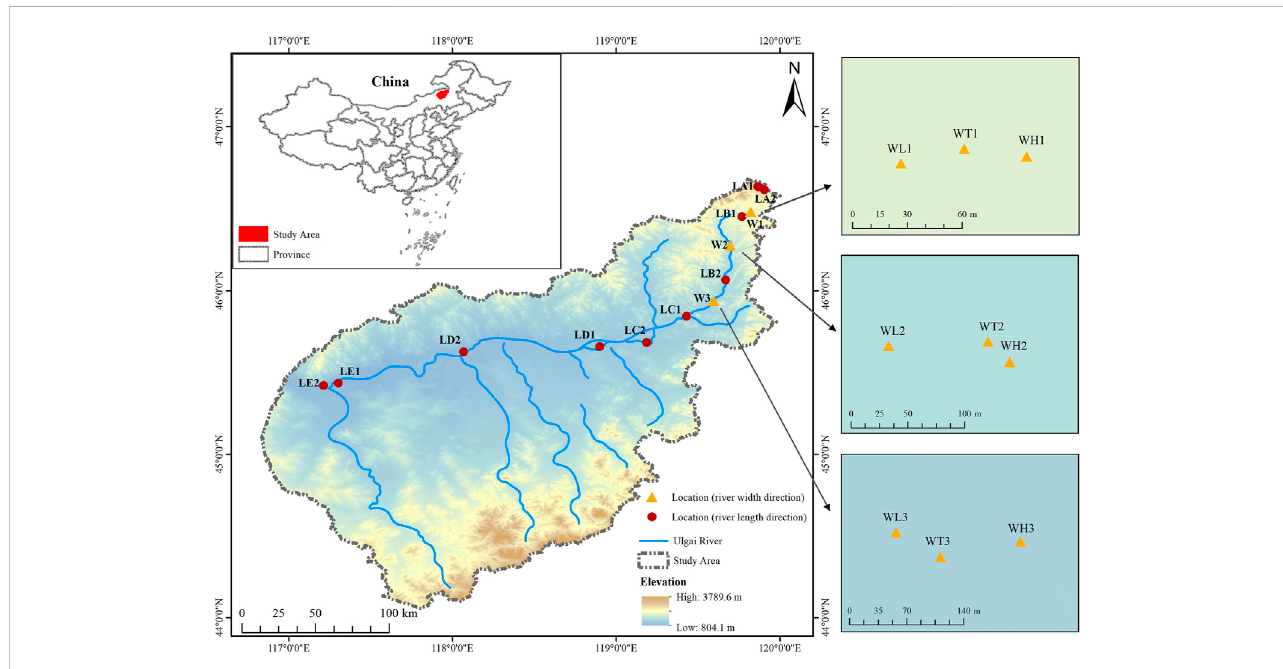
FIGURE 1 Distribution of sampling sites in the riparian zone of the Ulgai River. LA1/LA2: Source area; LB1/LB2: Upper reaches; LC1/LC2: Middle reaches; LD1/LD2: Lower reaches; LE1/LE2: Terminal lake; WL1/WL2/WL3: Low fl oodplain; WT1/WT2/WT3: Transition zone; WH1/WH2/WH3: High fl oodplain. The same is following Figures and